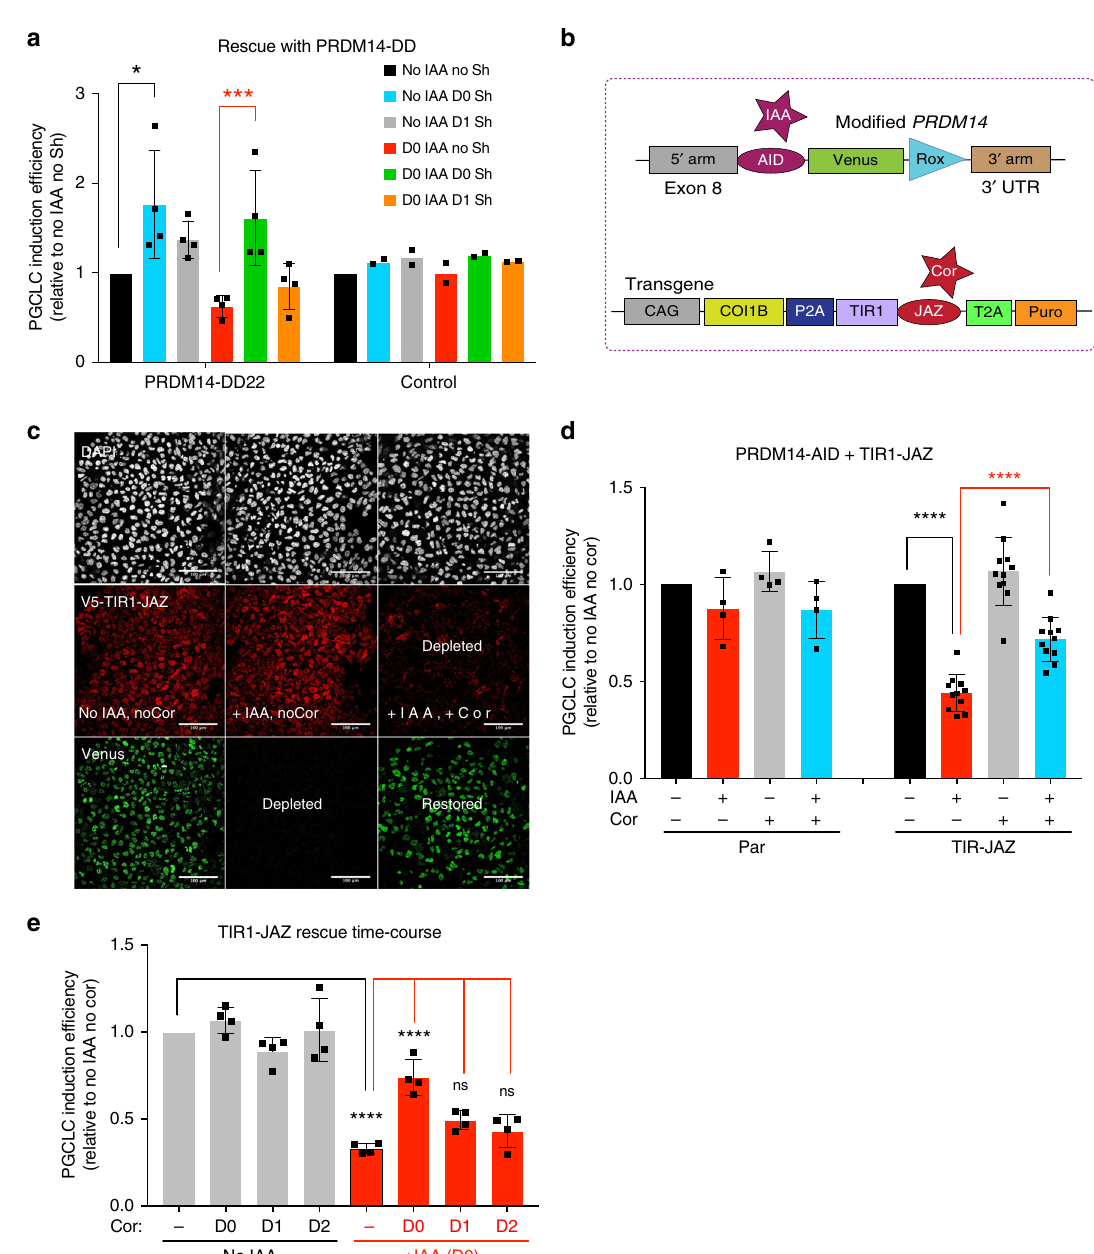
Fig. 5 Ectopic PRDM14 expression or desensitisation to auxin rescue hPGCLC speci fi cation. a IAA and/or Shield-1 (Sh) were added on indicated days of differentiation to deplete the endogenous PRDM14 or stabilise the PRDM14-DD transgene, respectively. “ Control ” cell line lacks both the AID knock-in and the PRDM14-DD transgene. Data show mean ± SD for n = 4 (PRDM14-DD22) or mean of n = 2 (control) independent experiments. Statistical signi fi cance was analysed by two-way ANOVA followed by Sidak ’ s multiple comparison test; for PRDM14-DD22: D0 IAA no Sh vs. no IAA no Sh not signi fi cant, ( P